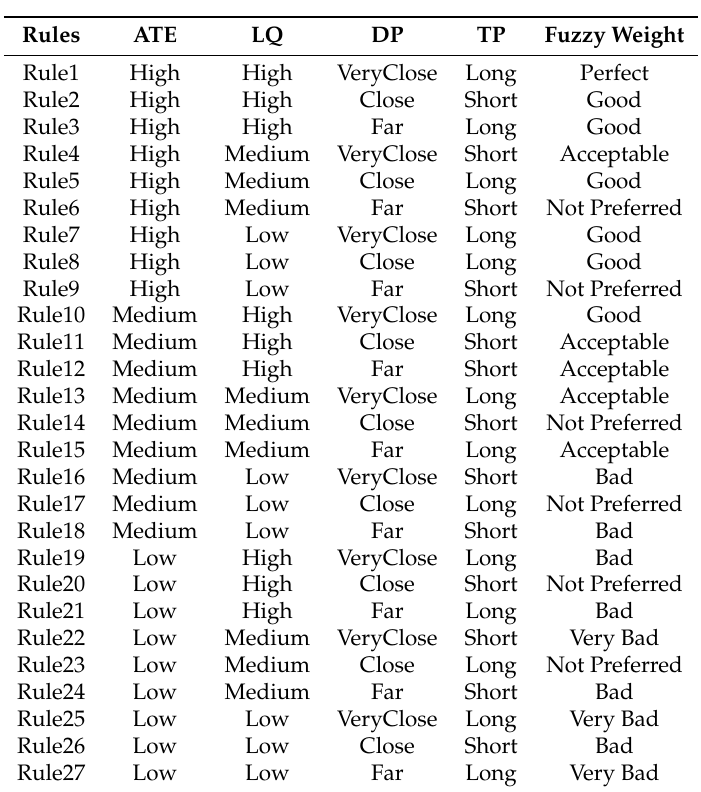
Table 2. Examples of fuzzy